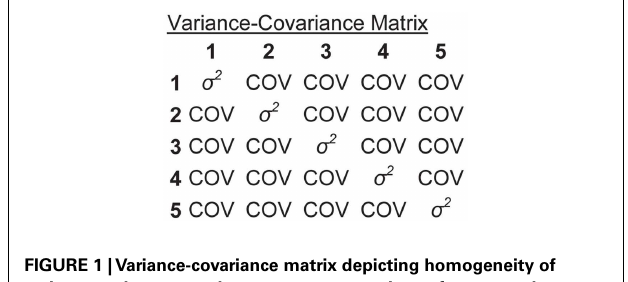
FIGURE 1 |Variance-covariance matrix depicting homogeneity of variance and compound symmetry assumptions of a repeated measuresANOVA with six repeated assessments